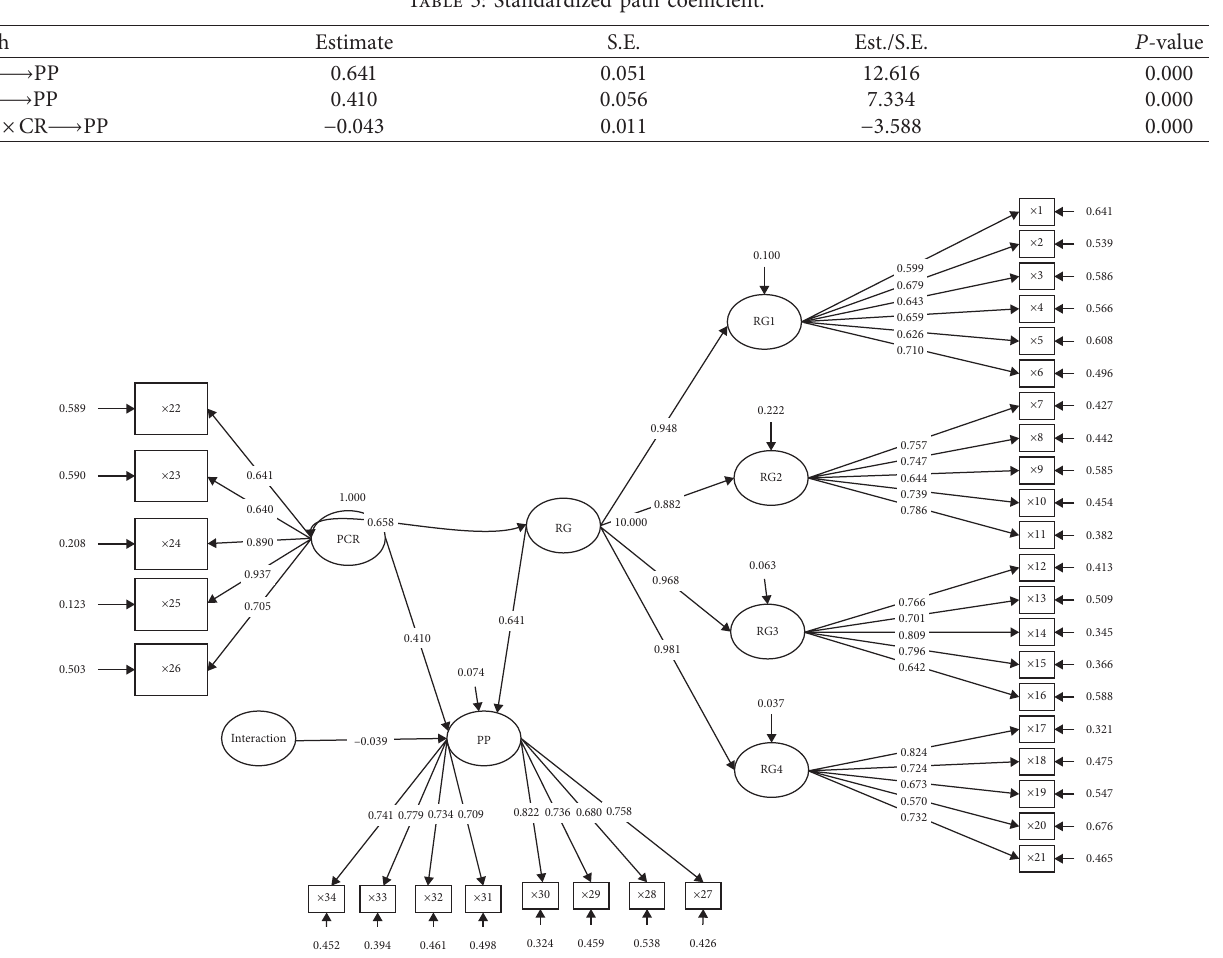
Figure 4: Impact of rule governance on project performance under the moderating effect of project control